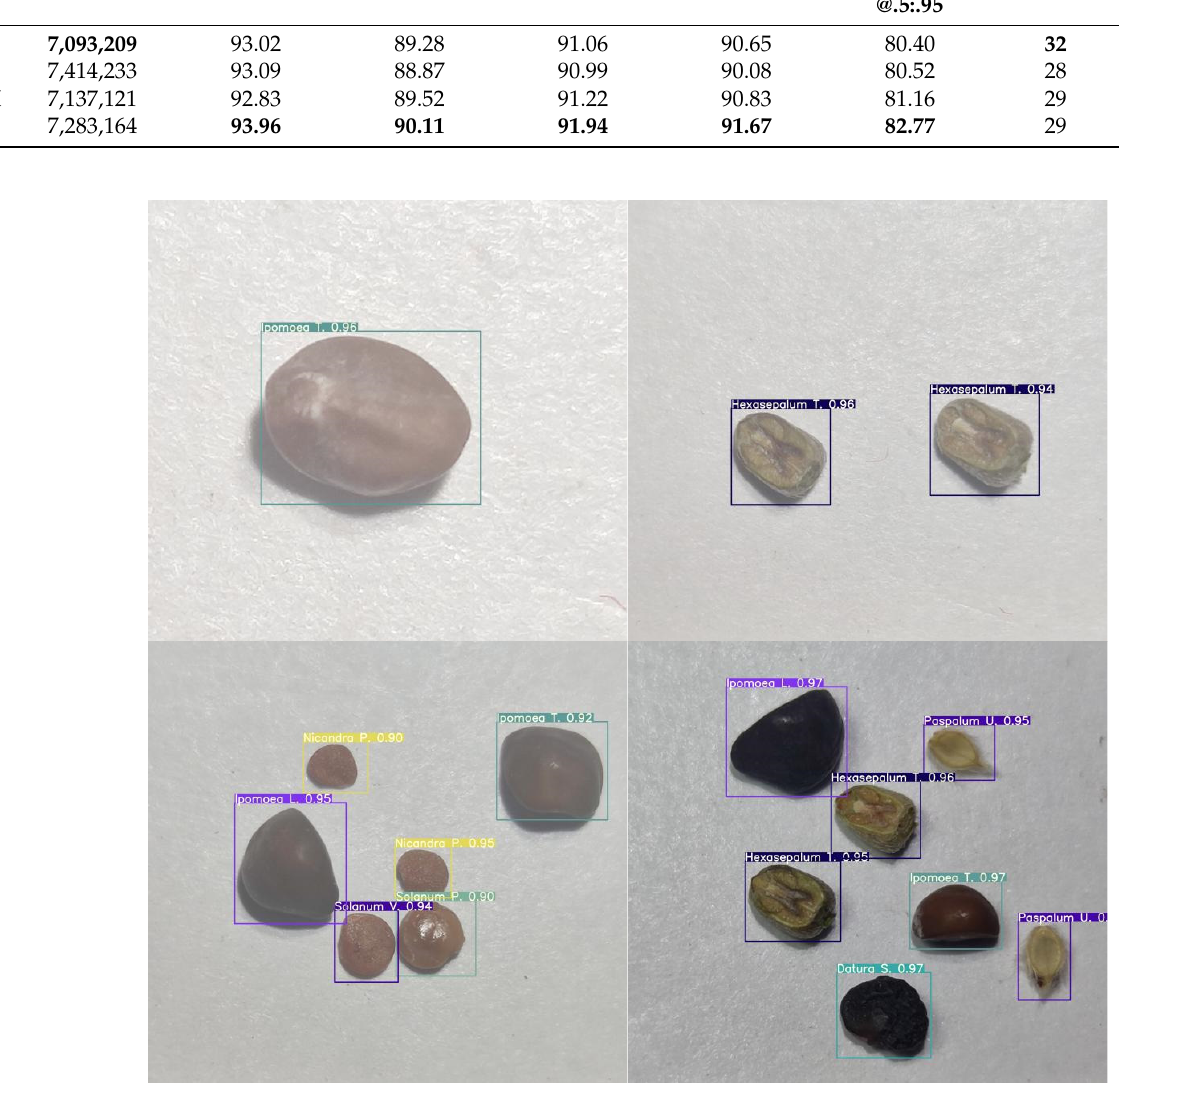
Figure 14. Partial prediction results of YOLOv5s+ECA model.